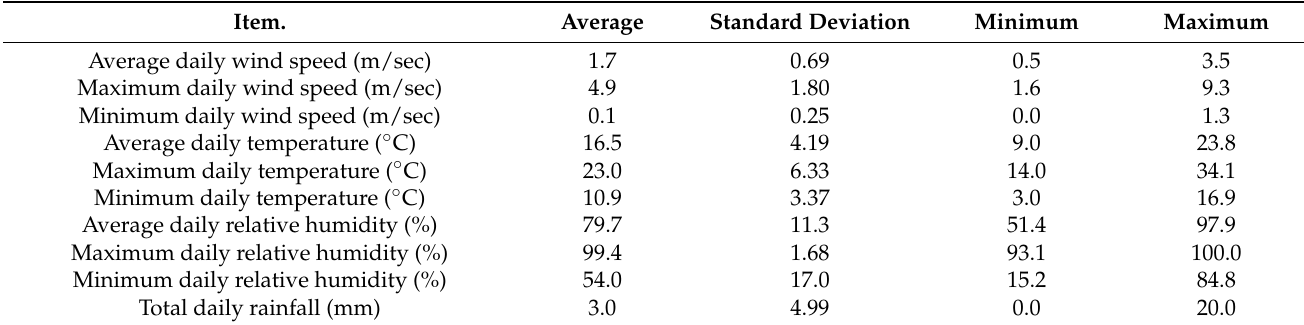
Table 2. Weather conditions during the 30 days (5 days for each of 6 cohorts) of the experiment when the SF 6 technique was used to measure